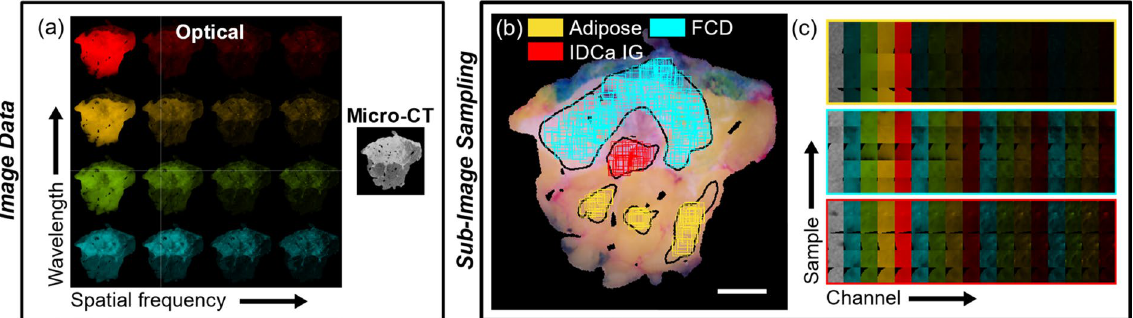
Figure 5. Overview of tissue imaging and sampling protocol. ( a ) Visualization of optical data collection at four wavelengths and four spatial frequencies along with micro-CT scanning of a representative tissue specimen. ( b ) Sub-image sampling from histologically confirmed regions of distinct tissue subtypes, and ( c ) sub-image samples grouped by tissue subtype (color borders) containing 17 channels of image data (16 optical, one micro-CT). FCD = fibrocystic disease. IDCa IG = invasive ductal carcinoma intermediate-grade.